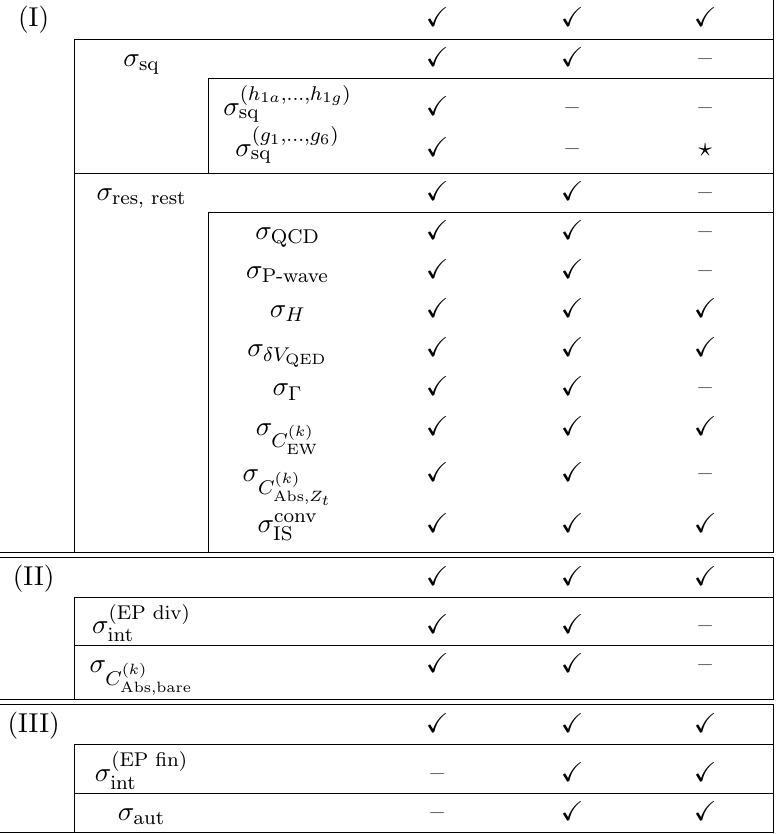
and (cid:27) ( g 1 ;:::;g 6 ) sq correspond to the virtual plus